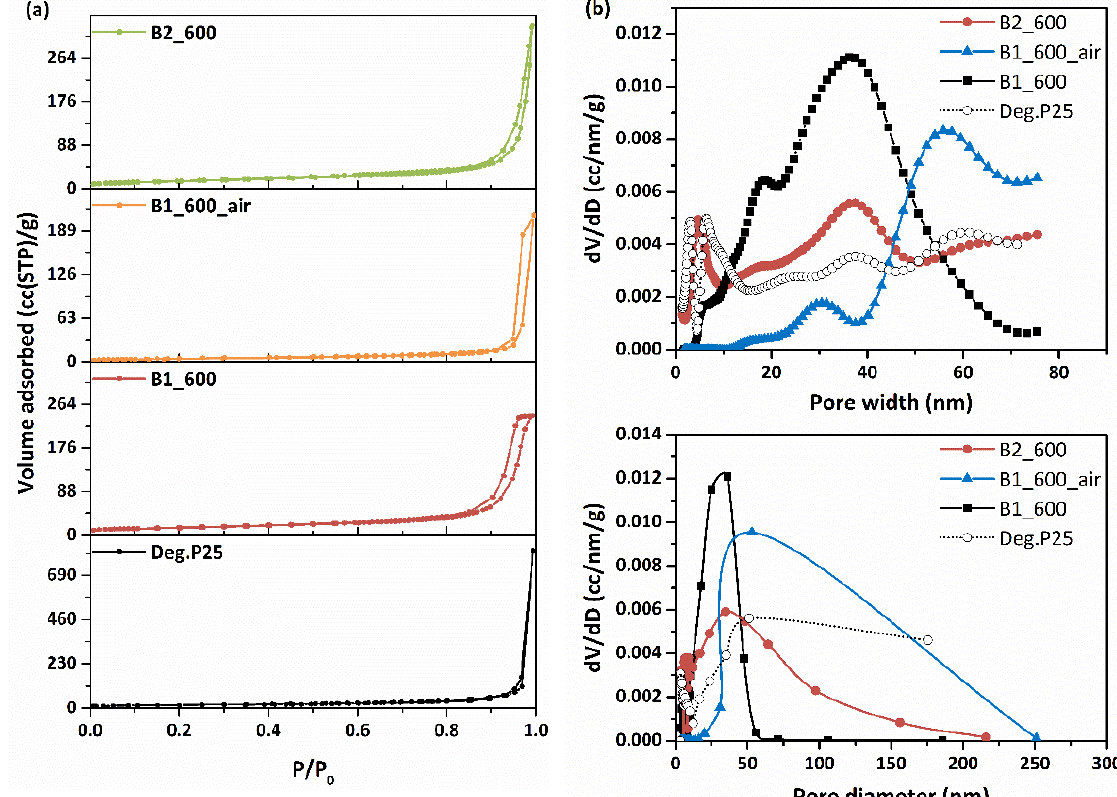
Figure 3. ( a ) N 2 adsorption (77 K) of the prepared ceramic beads in comparison to N 2 adsorption of Degussa P25 TiO 2 . ( b ) Pore size distributions calculated from the desorption branch of ceramic beads employing the BJH (bottom) and NLDFT (top) methods. Table 2. Pore characteristics and particle sizes of all samples. Sample